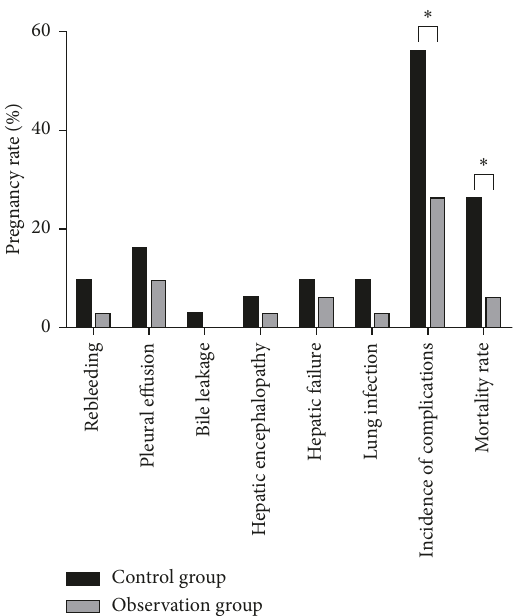
Figure 8: Comparison of complication incidence and mortality between the two groups. Note: compared with the control group, P 0 . 05. ∗ <